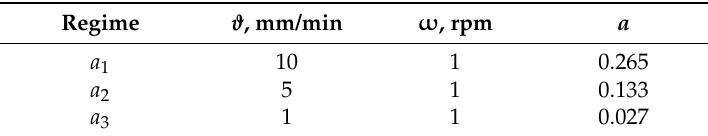
Figure 2. Dependence of the non-dimensional angular velocity of the sample, ω (cid:48) the sample, ξ , in the container channel. Table 1. High pressure torsion extrusion (HPTE) parameters for analysis of the model used to calculate the graphs presented in Figure